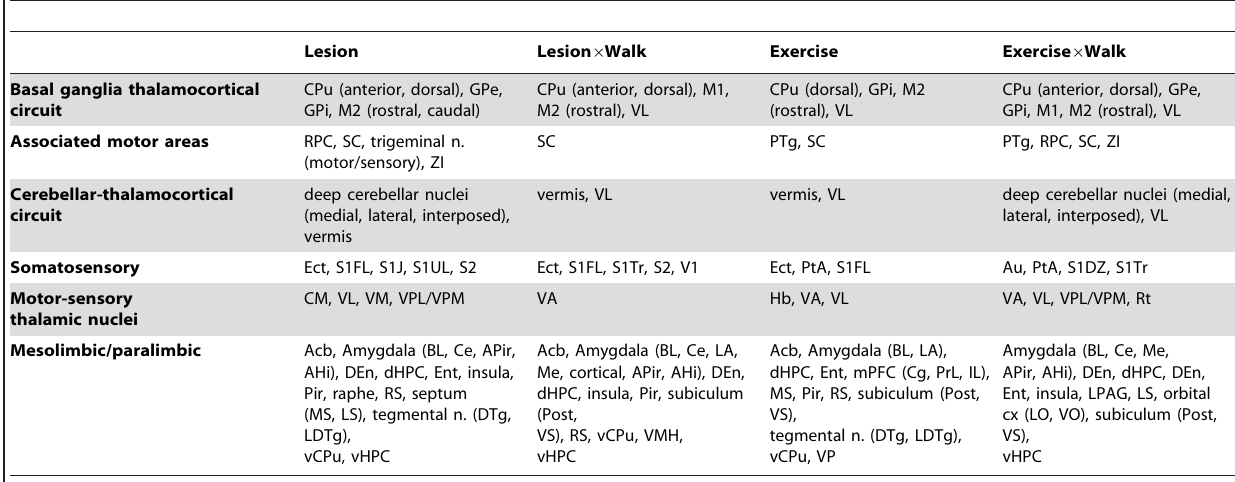
Table 3. Factorial analysis showing regions of statistical significant differences in functional brain activation.